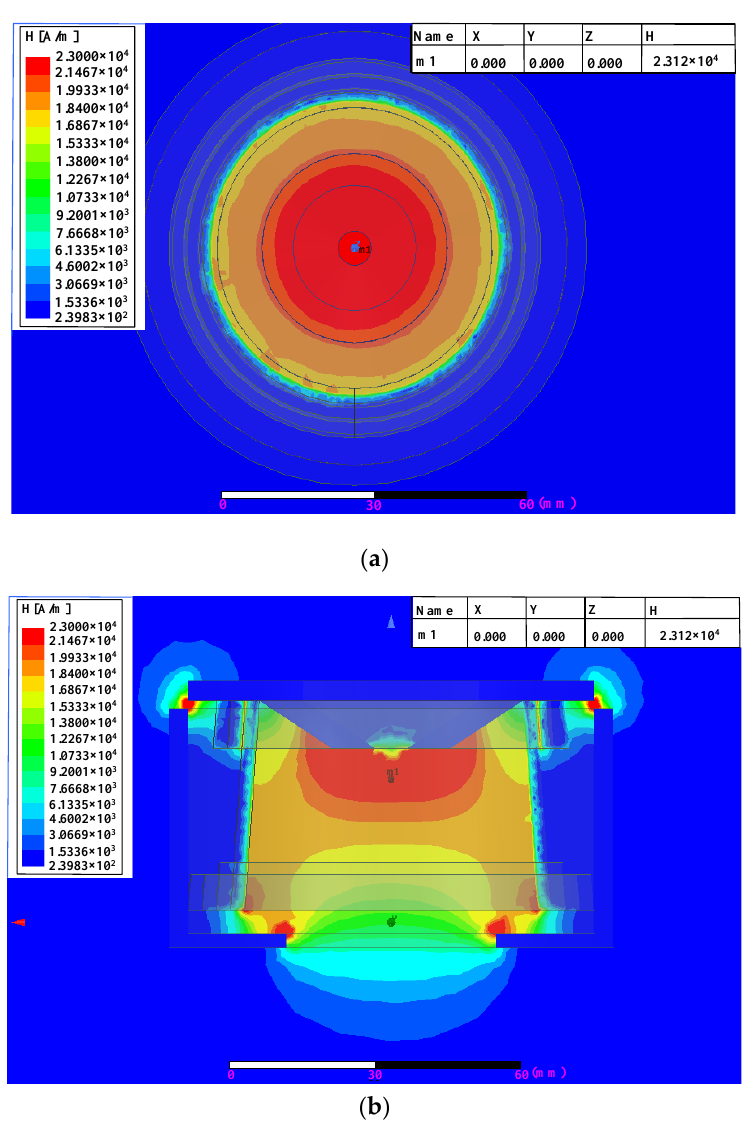
Figure 7. The simulated electromagnetic field of the final coil: ( a ) X–Y section of the magnetic field; and ( b ) X–Z section of the magnetic field.